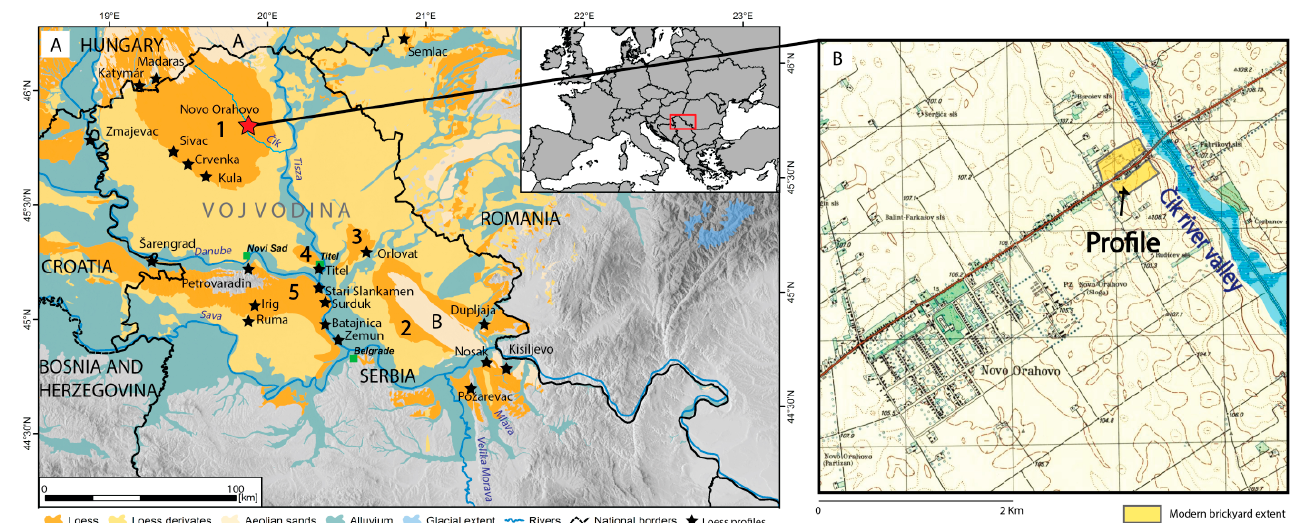
Figure 1. Distribution of the loess sediments and loess derivates in the southeastern Carpathian Basin with the position of the Novo Orahovo loess section and other key loess sites in the region. Distribution of loess, loess derivates, aeolian sand, and alluvium according to Lehmkuhl et al. (2018) [10] and JAXA EORC (2016) [11], respectively. Loess plateaus (LP): 1. Ba č ka LP; 2. Banat LP; 3. Tamiš LP; 4. Titel LP; 5. Srem LP. Sandy terrains (ST): ( A ) Ba č ka ST; ( B ) Banat ST. Modi fi ed after Peri ć et al. (2022) [12].